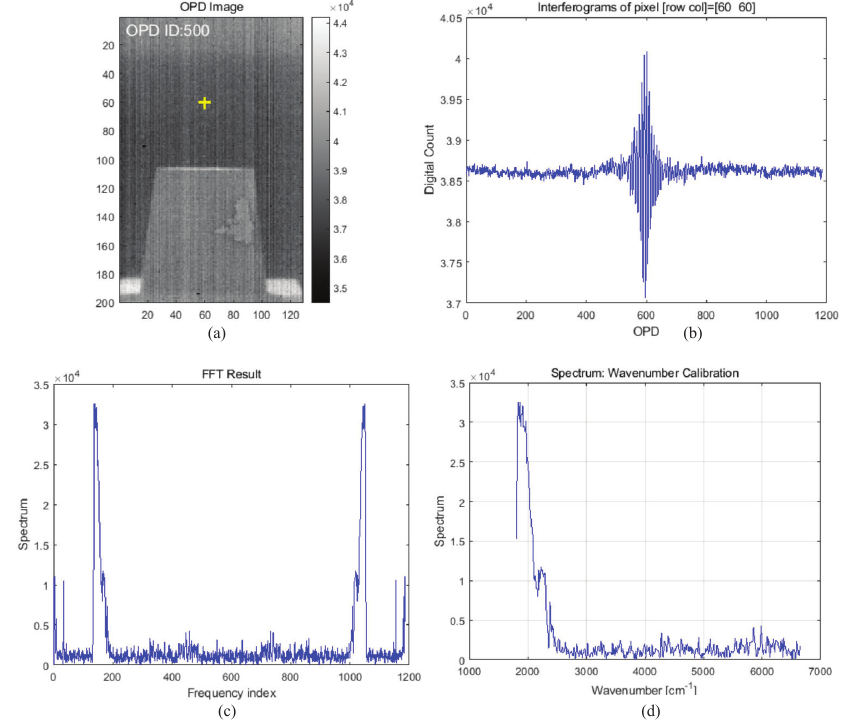
Figure 3. Spectral calibration process: ( a ) interferogram image at optical path difference (OPD) ID = 500 (ZPD); ( b ) interferogram at a pixel ((row, col) = (60, 60)); ( c ) fast Fourier transform (FFT) results; ( d ) wavenumber calibration